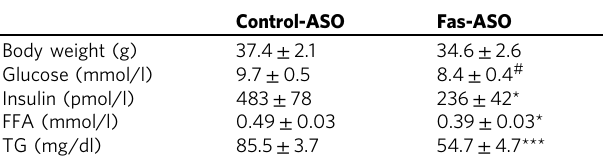
Mice were fasted for 5h before blood sampling. Values are expressed as mean ± s.e.m., n = 5 * P < 0.05, *** p < 0.001, and # p = 0.08 (Student ’ s t-